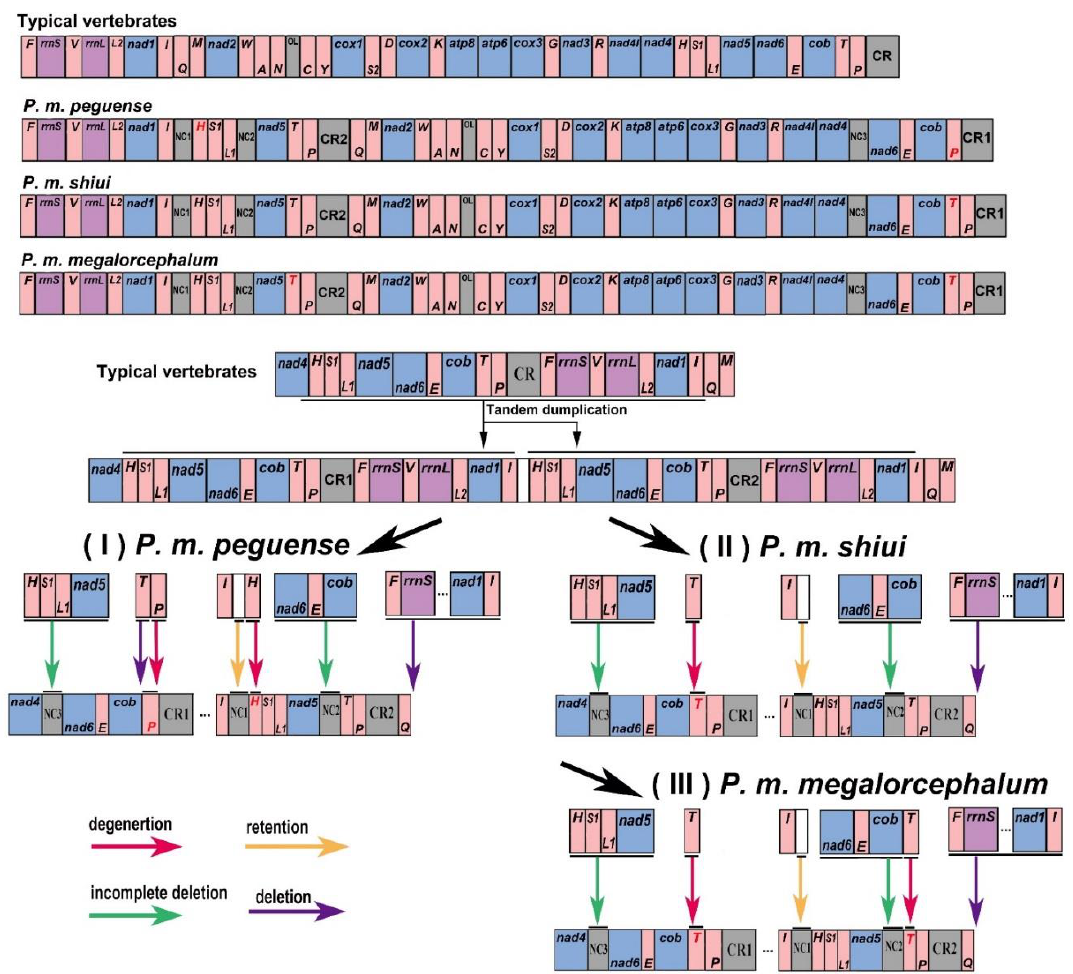
Figure 3. Mitogenome features and putative gene rearrangement process of P. m. peguense (type (I)), P. m. shiui (type (II)), and P. m. megalorcephalum (type III) of the three investigated Platysternon subspecies. The gene name above the median indicates encoding by the H-strand (+), while the gene name below the median indicates encoding by the L-strand (−). Red font indicates degenerated tRNA genes, and tRNA genes are designated using single-letter amino acid codes.